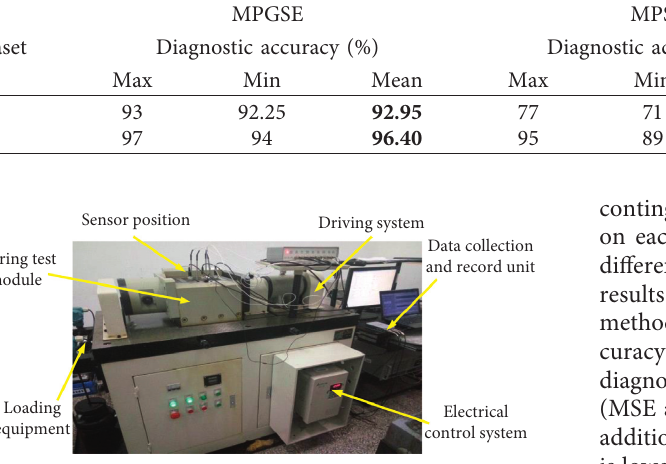
Figure 24: Structure of the experimental